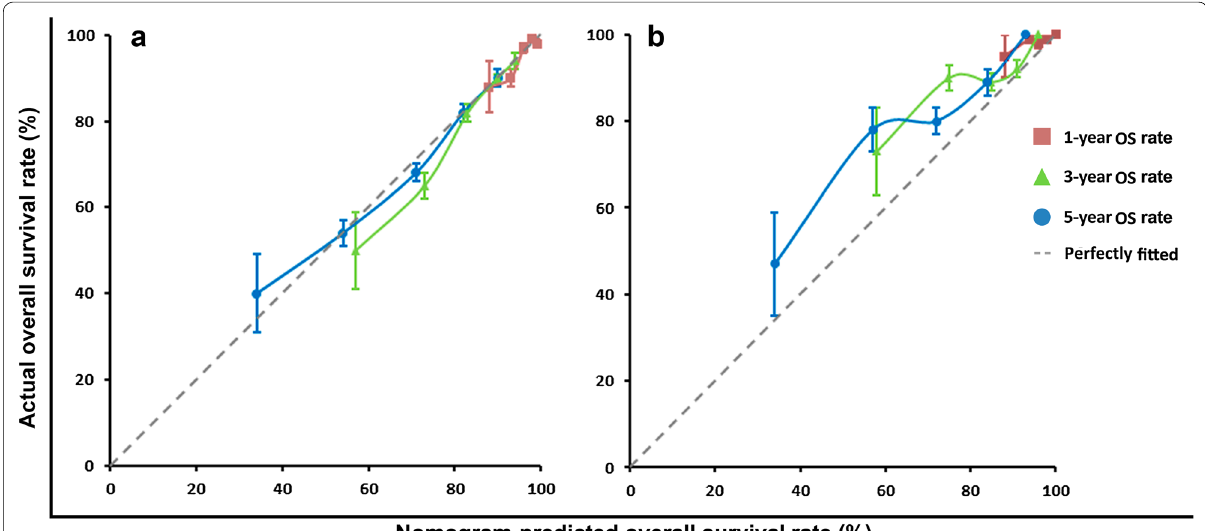
Fig. 2 The calibration curve for predicting overall survival (OS) of patients with non-metastatic NPC in the internal validation set ( a ) and intensity- modulated radiation therapy (IMRT) cohort ( b ). The nomogram-predicted probability of OS is plotted on the x-axis; the actual OS is plotted on the y-axis